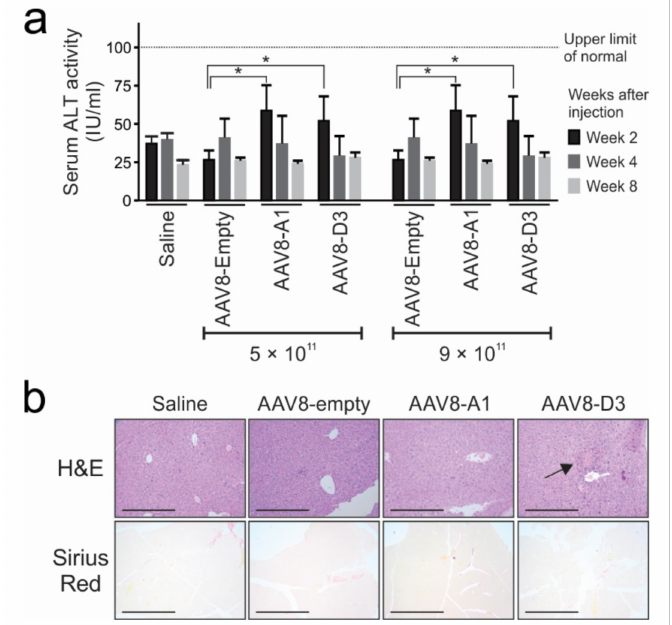
Figure 5. Assessment of inflammation and toxicity in liver tissues from AAV8 HBV-infected mice. ( a ), Alanine transaminase (ALT) activity in serum collected from mice treated with saline or AAVs. Means and SEM were calculated from data obtained from 4 mice per group. Statistically significant differences between samples were calculated using Student’s two-tailed paired t -test. p values of ≤ 0.05 (*) were considered statistically significant. The black dotted line indicates threshold of accepted upper limit of the normal range (<100 IU/L). ( b ), Haematoxylin and eosin (H&E) and Sirius red staining of liver sections collected at 24 weeks post-injection with AAVs or saline. Low-power fields with scale bars of 200 µ m are shown, and tissues were visualised at 40 × magnification. The black arrow indicates minimal inflammation, with blue dots representing the nuclei of infiltrating mononuclear